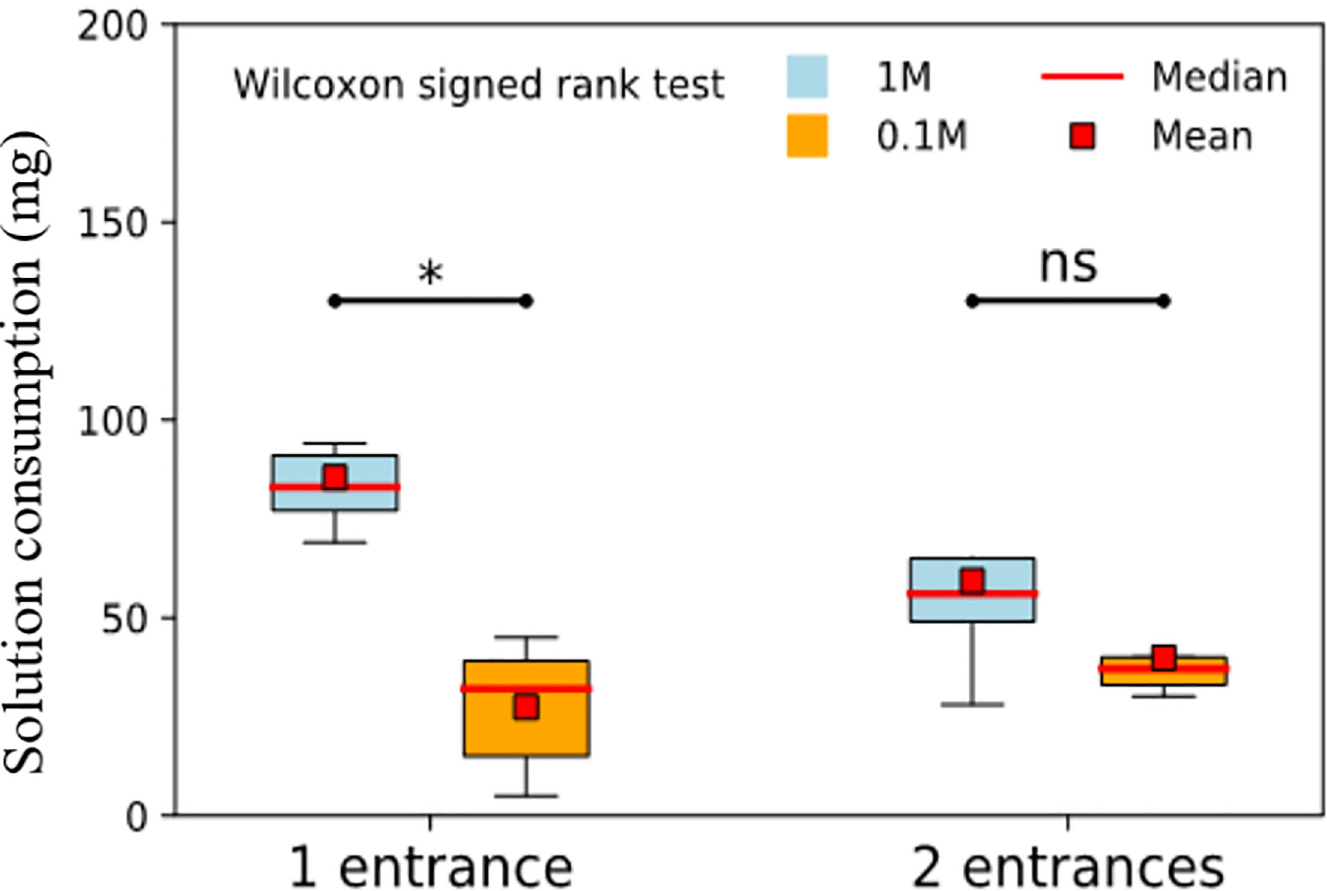
Fig 8. Total amount of sucrose solution retrieved from the 1M and 0.1 feeders in each nest entrance configuration. We measured the ingested amount of sucrose solution at the end of the experiment for one- and two-entrance nests. Blue and orange boxplots represent the food solution consumption at 1M and 0.1 M feeders respectively. Presented are medians and quartiles, red squares indicate means and circles indicate outliers (n = 9, Wilcoxon signed rank test).